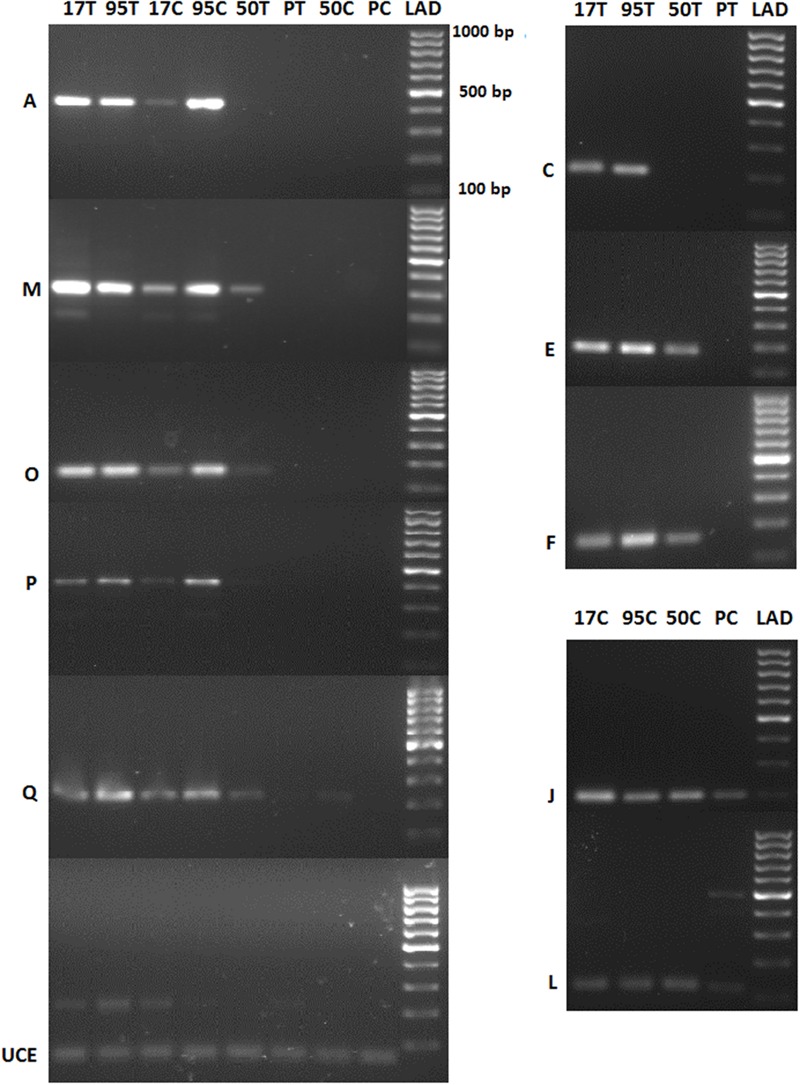
PCR expression analysis of selected differentially expressed buffalograss genes. 17, 50, 95, and P refer to NE BG 7-3459-17, NE BG 7-3453-50, 95–55 and Prestige, respectively. C and T followed by the buffalograss lines indicate untreated and treated samples. Ubiquitin conjugating enzyme (UCE) is the endogenous gene and positive control. A, M, O, P, and Q are genes which had >10 read counts for both treated and untreated resistant buffalograss lines (95T, 17T, 95C, and 95C) and zero read counts for all susceptible lines (PT, 50T, PC, and 50T). The read counts of treated resistant lines were up-regulated in C, E, and F compared to the treated susceptible lines. J and L genes had higher read counts in untreated resistant lines compared to the untreated susceptible lines. LAD is the molecular marker.